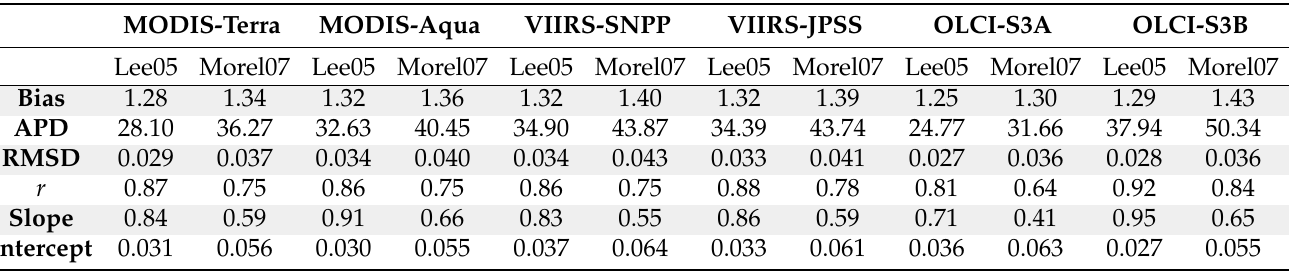
Figure 5. Results of the comparison between the satellite-derived K d ( PAR ) R rs and the float-retrieved K d ( PAR ) float , for two different PAR algorithms: ( a ) K d ( PAR ) R rs vs. K d ( PAR ) float colored by solar zenith angle with each marker shape indicating a different sensor; the dashed line indicates the 1:1 line; K d ( PAR ) Lee 05 vs. K d ( PAR ) float (left), K d ( PAR ) Morel vs. K d ( PAR ) float (center) K d ( PAR ) Lee 05 vs. K d ( PAR ) Morel (right); ( b ) ratio for each of the two algorithms against K d ( PAR ) float ; the solid line is a ratio of 1 and the dashed black lines denote ratios of 0.75 and 1.25. Table 5. Summary statistics for all satellite sensors at the global scale for both PAR algorithms. See Methods section for definitions of statistical